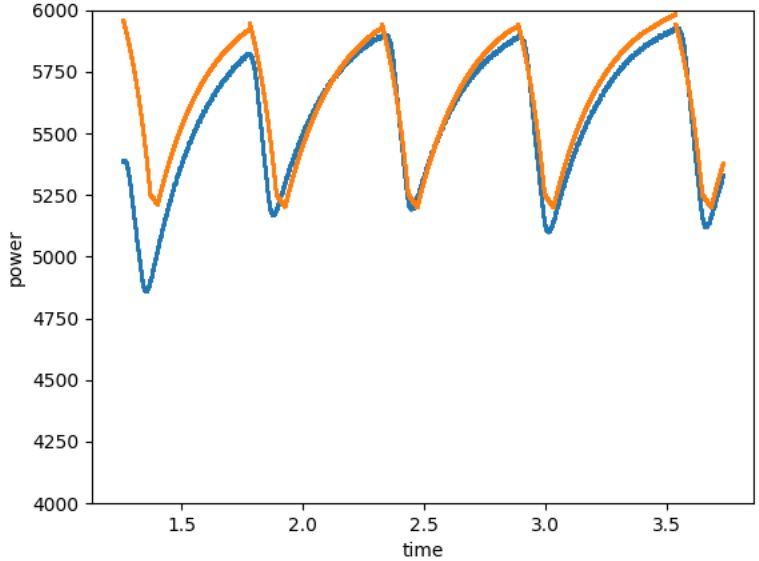
Figure 15. Profile estimated by the neural network with Mode